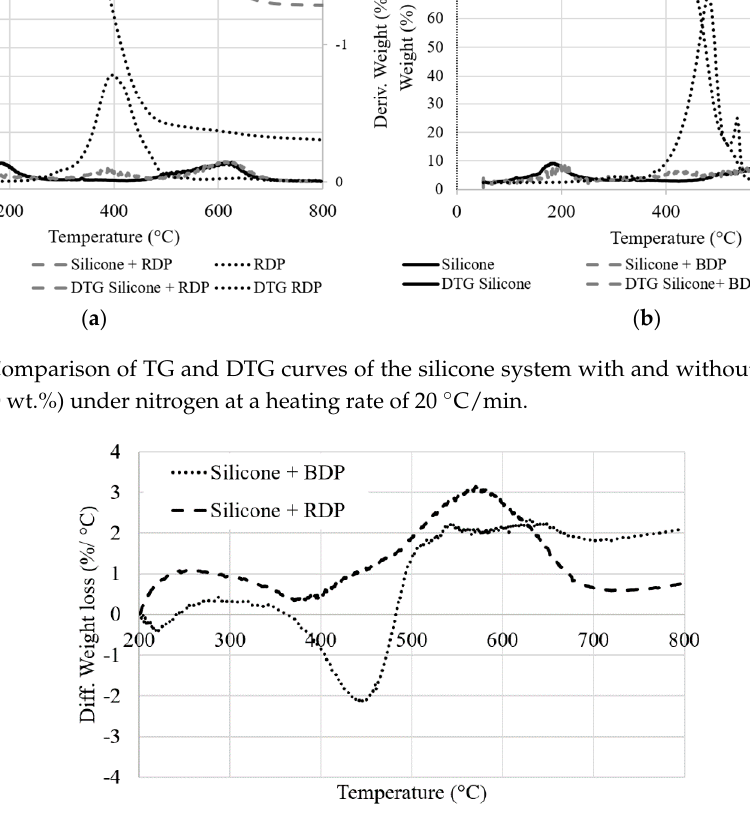
Figure 7. Weight difference curves between experimental and calculated TG curves when RDP or BDP is added to the resin (10 wt.%) under N 2 conditions.